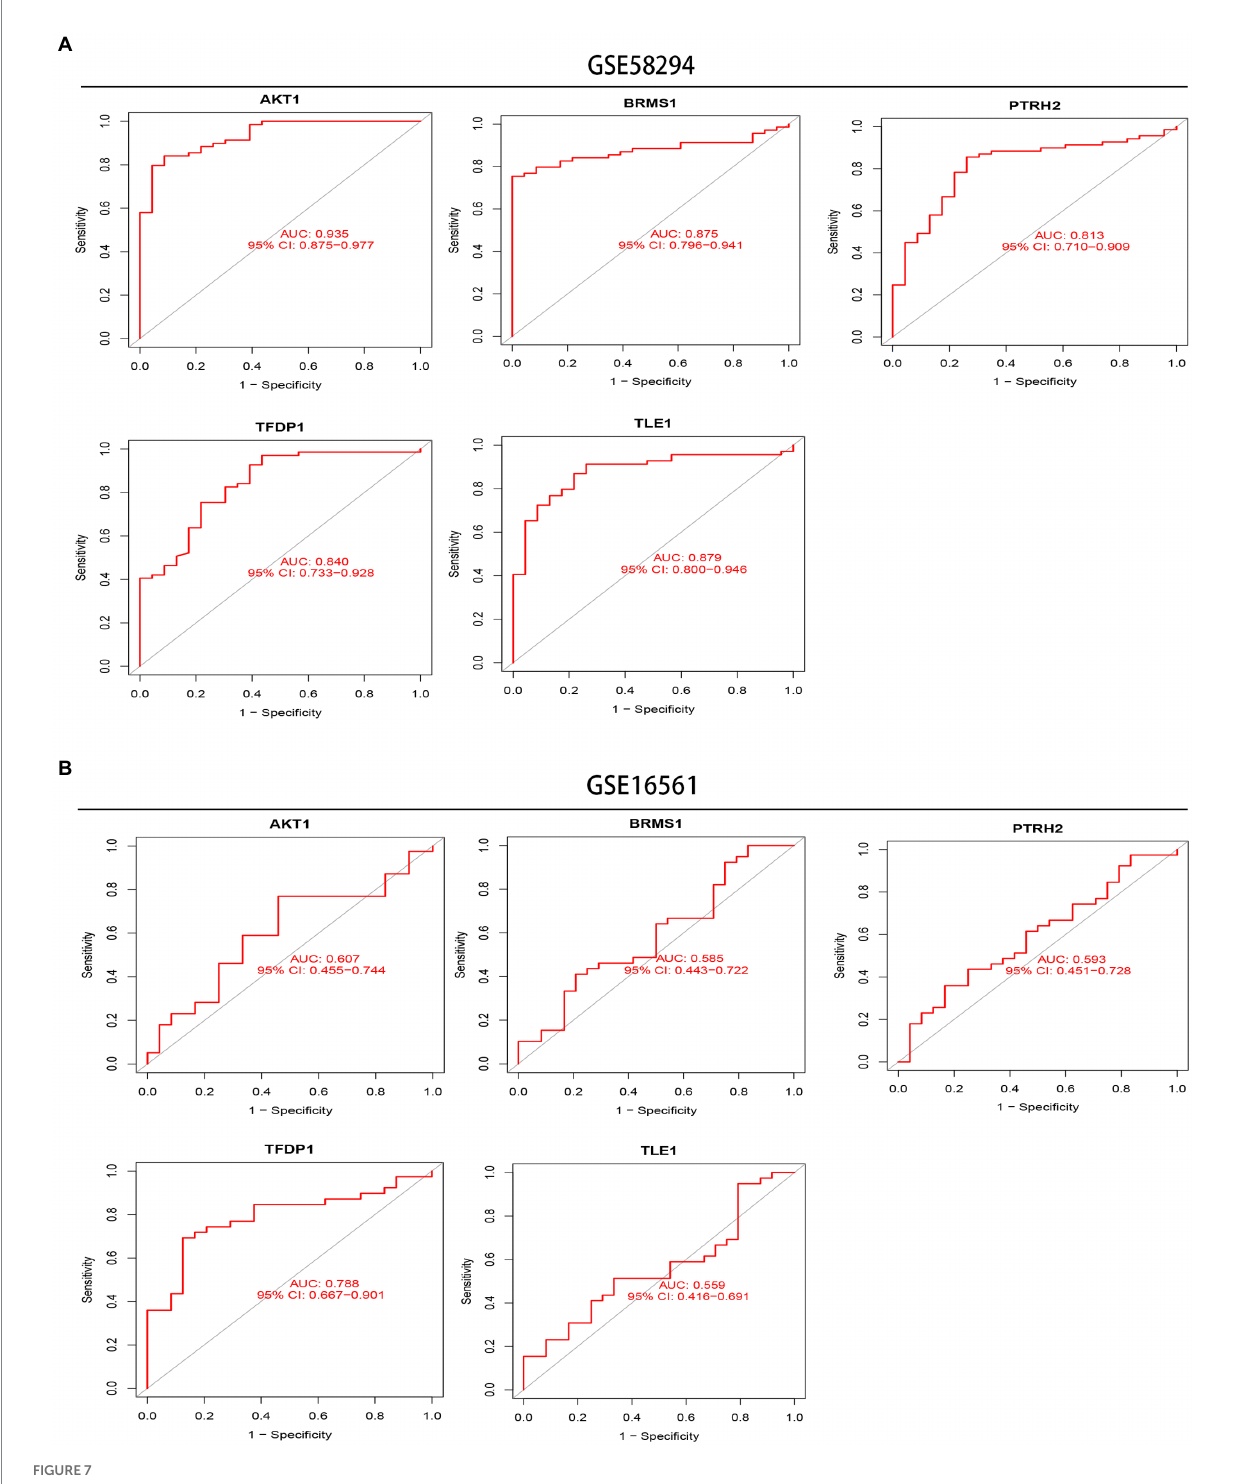
FIGURE 7 Exploration of the diagnostic value of 5 signature genes. (A) ROC curves showing the diagnostic value of the 5 signature genes in the GSE58294 dataset. (B) ROC curves showing the diagnostic value of the 5 signature genes validated in the GSE16561